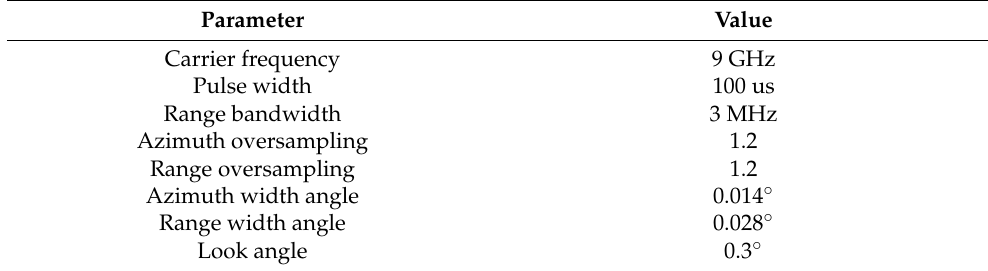
Table 7. Basic system parameters of